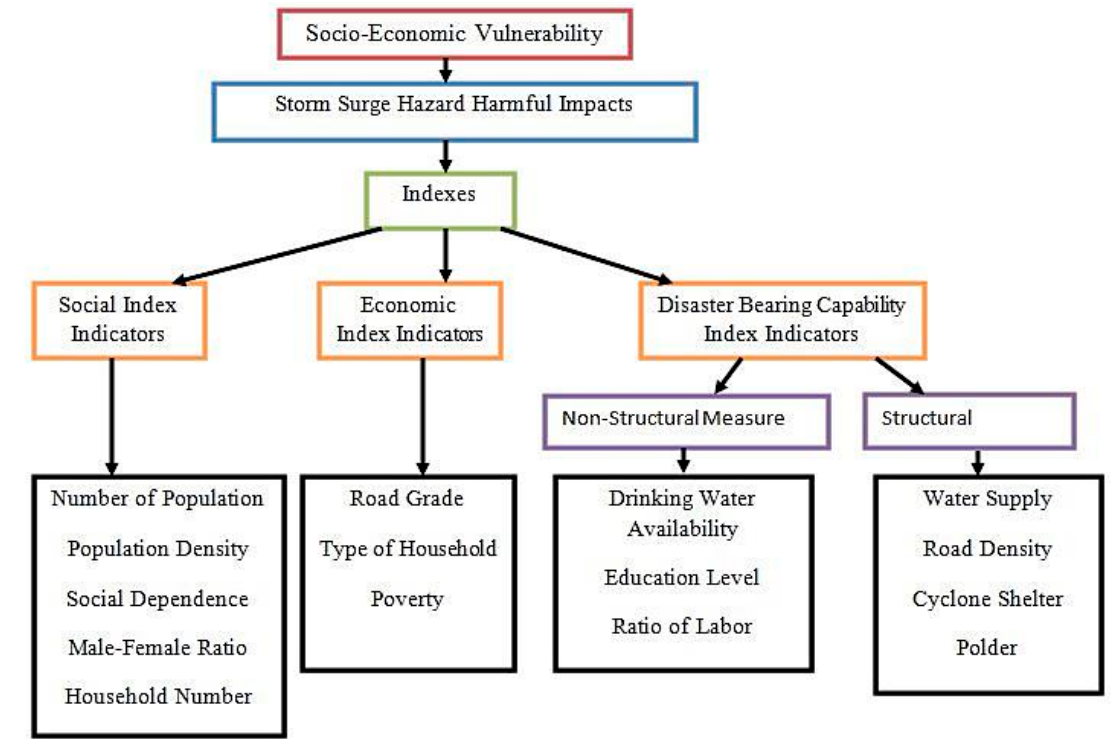
Figure 1. Flowchart of socio-economic vulnerability assessment for storm surge hazard.